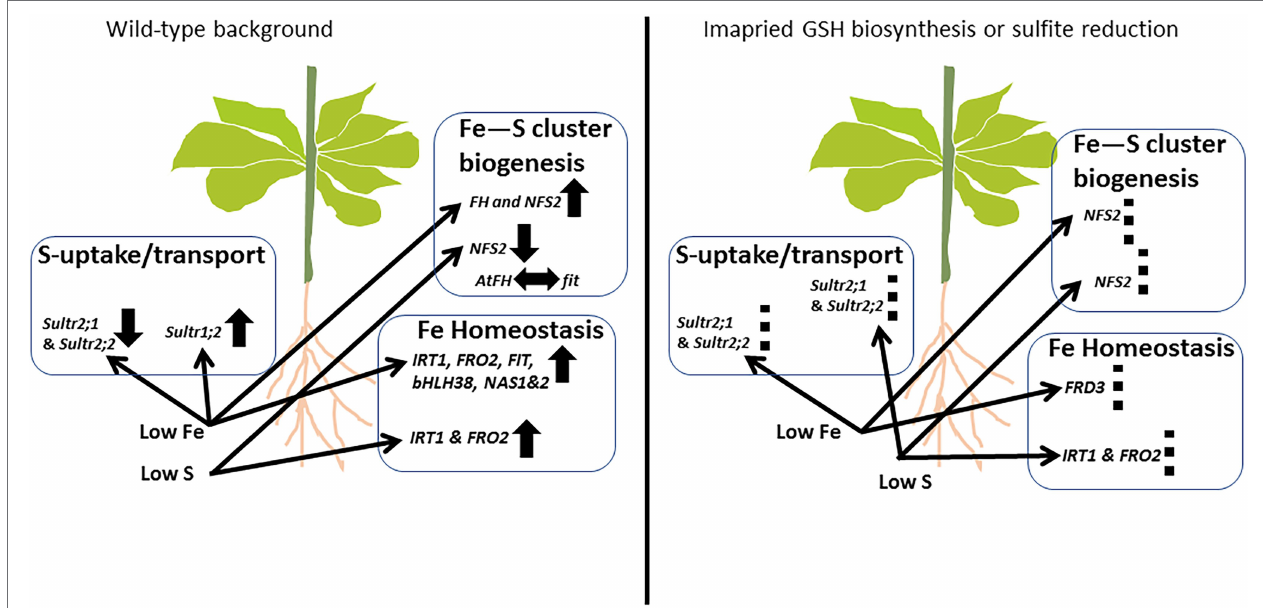
FIGURE 6 | Schematic representation of the interplay between iron and sulfur networks in Arabidopsis . The availability of Fe and S affect the expression of S and Fe homeostasis related gene in plants. The response pattern might depend on the severity/degree of nutrient deficiency. Bottlenecks in sulfite reduction and/or GSH biosynthesis ( right panel ) can futher modulate the cannonical responses via still unknown signals like ROS (Astolfi et al., 2021; von der Mark et al., 2021; McInturf et al., 2022) and others. UP arrows: Upregulation; down arrows: downregulation; left–right arrow: probable interaction; and dashed-lines: differential regulation compared to wild-type